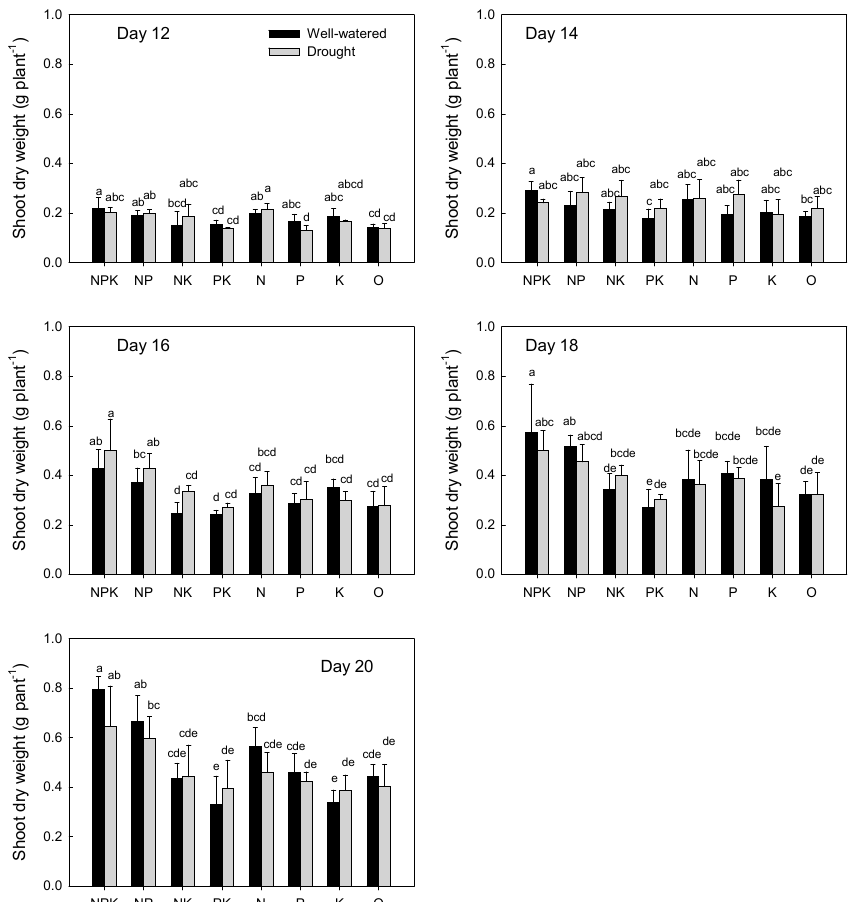
Figure 4. Interactive effects of drought and the N, P and K nutrients applied individually or in combination, or with no nutrient application (0) on the shoot dry weight of the maize seedlings at days 12, 14, 16, 18 and 20 after sowing. The error bars represent the standard errors of the mean ( n = 3) and fit within the plot symbol if not visible. Means accompanied by different letters are significantly different at p < 0.05.